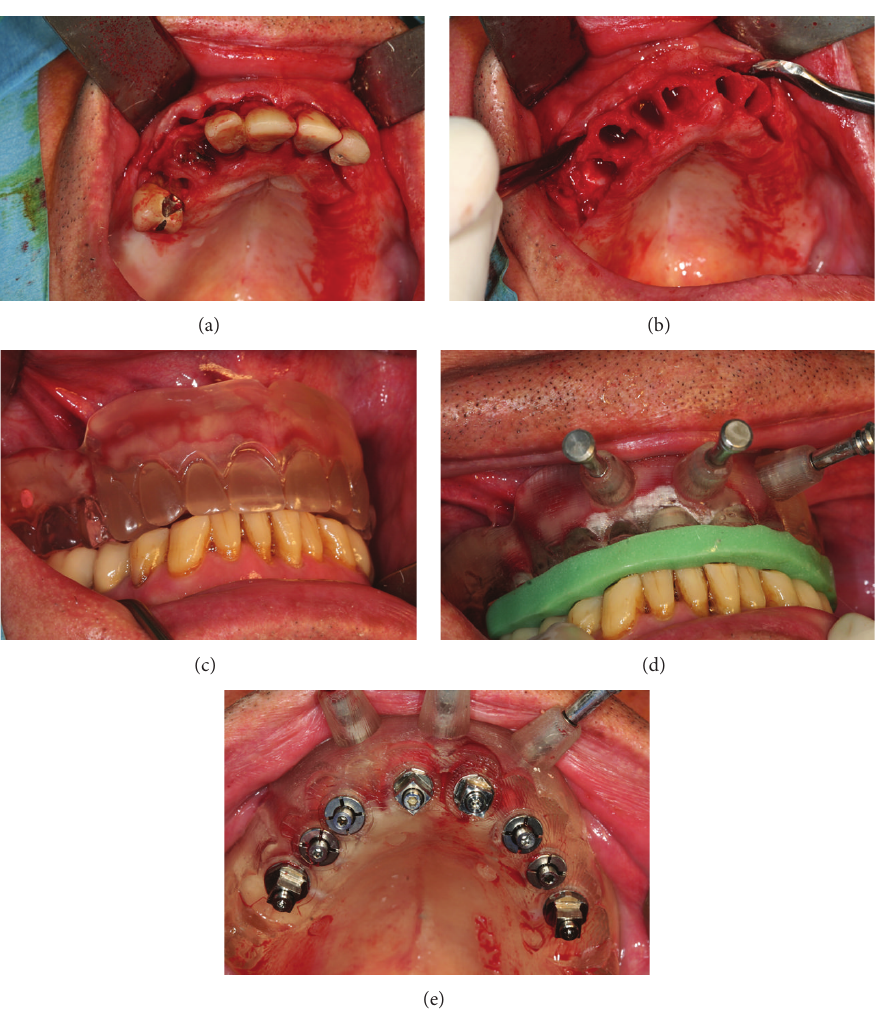
Figure 5: ((a) and (b)) Extraction of the 6 remaining teeth. (c) Blanching of the mucosa in a homogeneous way proves the correct positioning of the conventional surgical guide. (d) The stereolithographic surgical guide can thus be correctly placed via a lab-made occlusal index (using the articulator) and then stabilized with 3 transfixation screws. (e) Eight implants have been inserted according to the NobelGuide